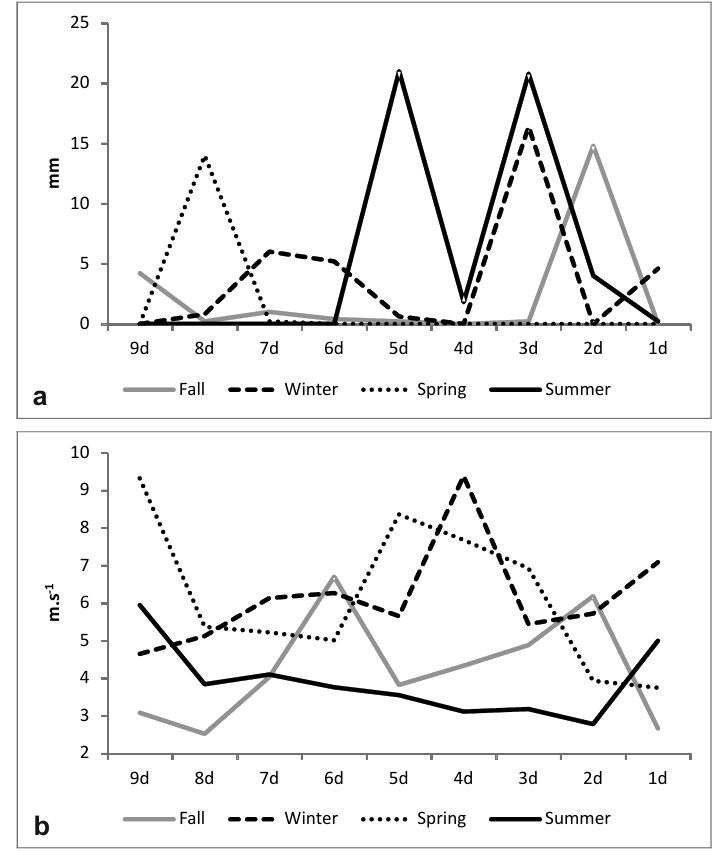
Figure 2 - Precipitation ( a ) and wind velocity ( b ) during the 7 days (d) before the sampling dates (1d and